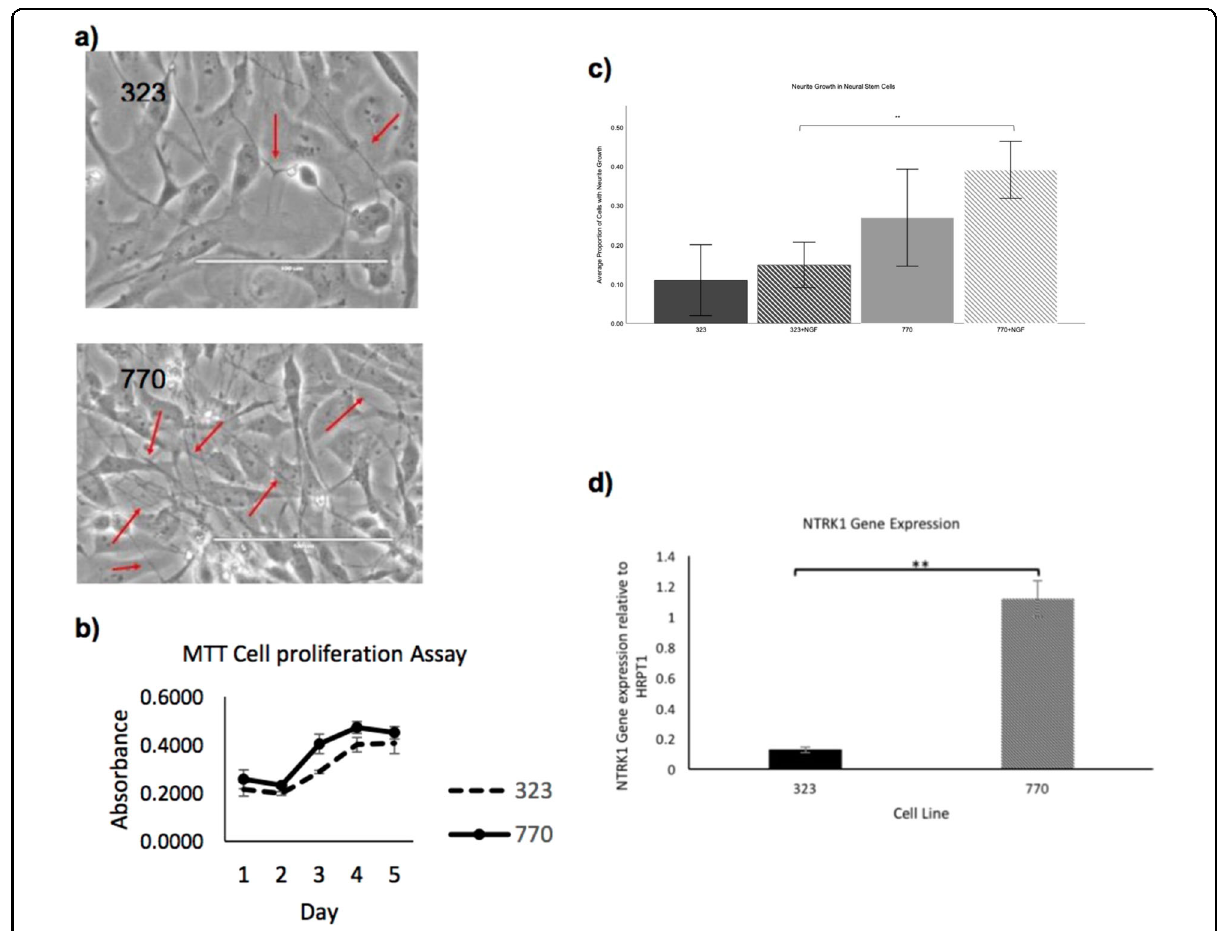
Fig. 2 Functional analysis using neural stem cells. a NSC line morphology of E492K mutant line (323) and control line (770) with red arrows indicating neurite growth. NSC line 770 also appears to have denser growth of cells and more neurite outgrowth. b Cell proliferation measured by absorbance of formazan in NSC lines. ( n = 3). c Proportion of neural stem cells in a given fi eld with at least one neurite outgrowth with or without NGF treatment. Control cell line (770) has a signi fi cantly higher (One way ANOVA; n = 12, ** p < 0.01) proportion of cells with neurite outgrowth when treated with NGF. d NTRK1 expression of NSCs. NTRK1 expression of the control cell line, 770, is signi fi cantly different (Independent T -test; ** p < 0.01) when compared to the mutant cell line,